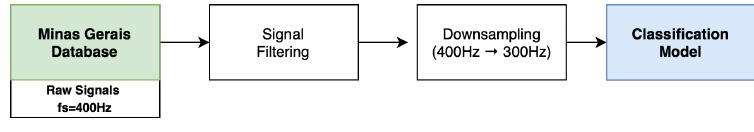
Figure 2. TNMG Signal Processing